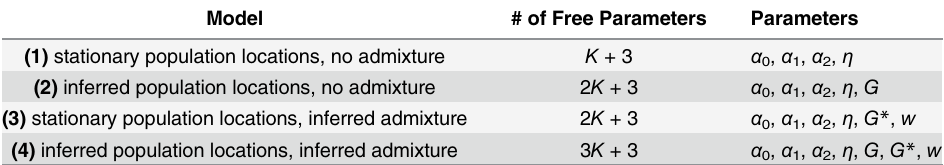
Table 1. List of models that may be specified using SpaceMix, along with the number and identity of free parameters in each. Model # of Free Parameters